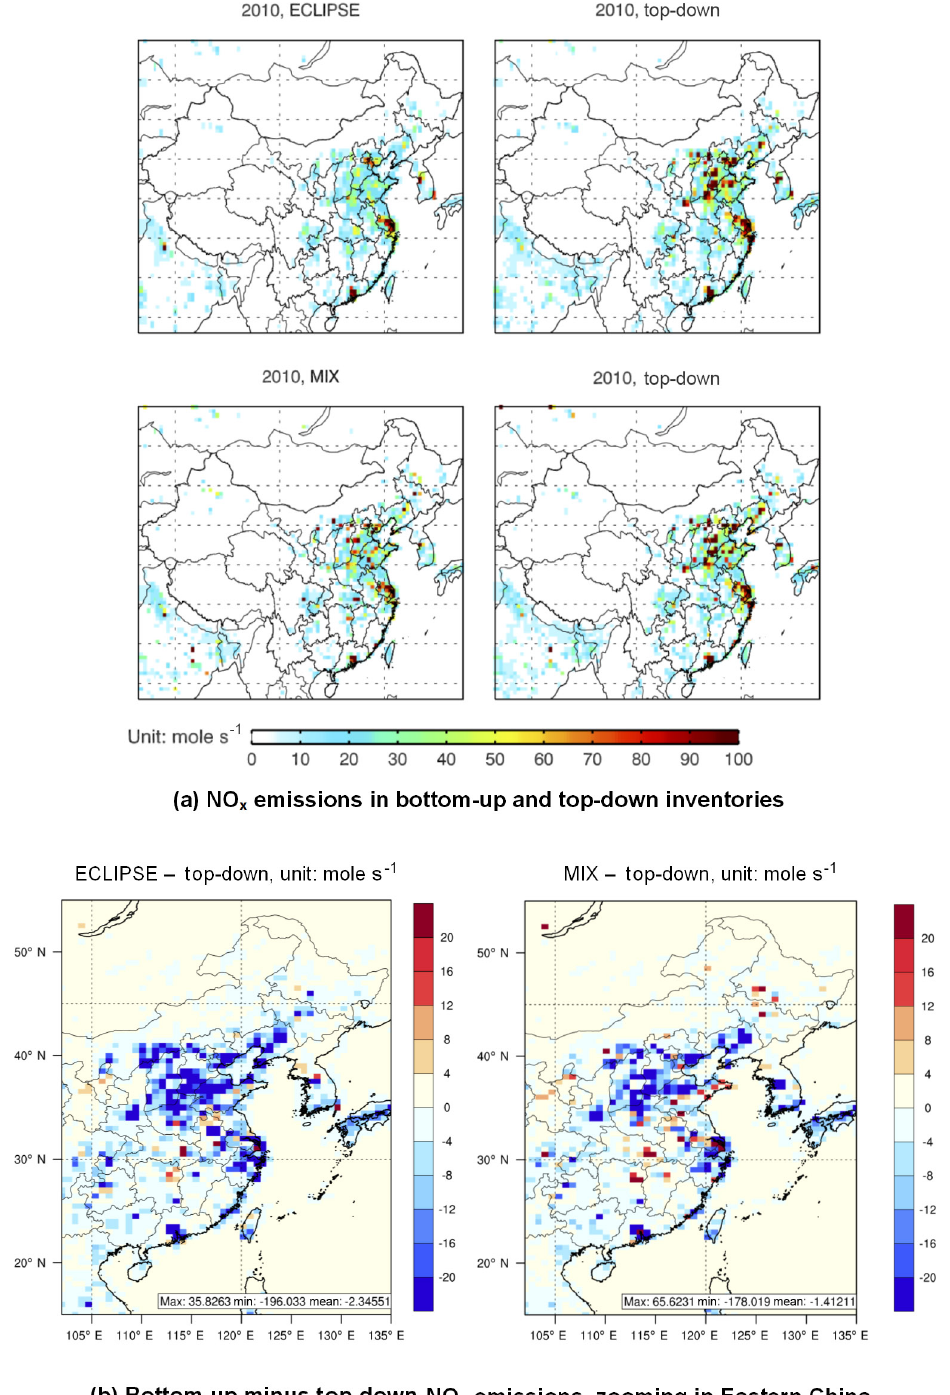
Figure 9. Comparisons among ECLIPSE, MIX and top-down emissions of NO x ; summer average in